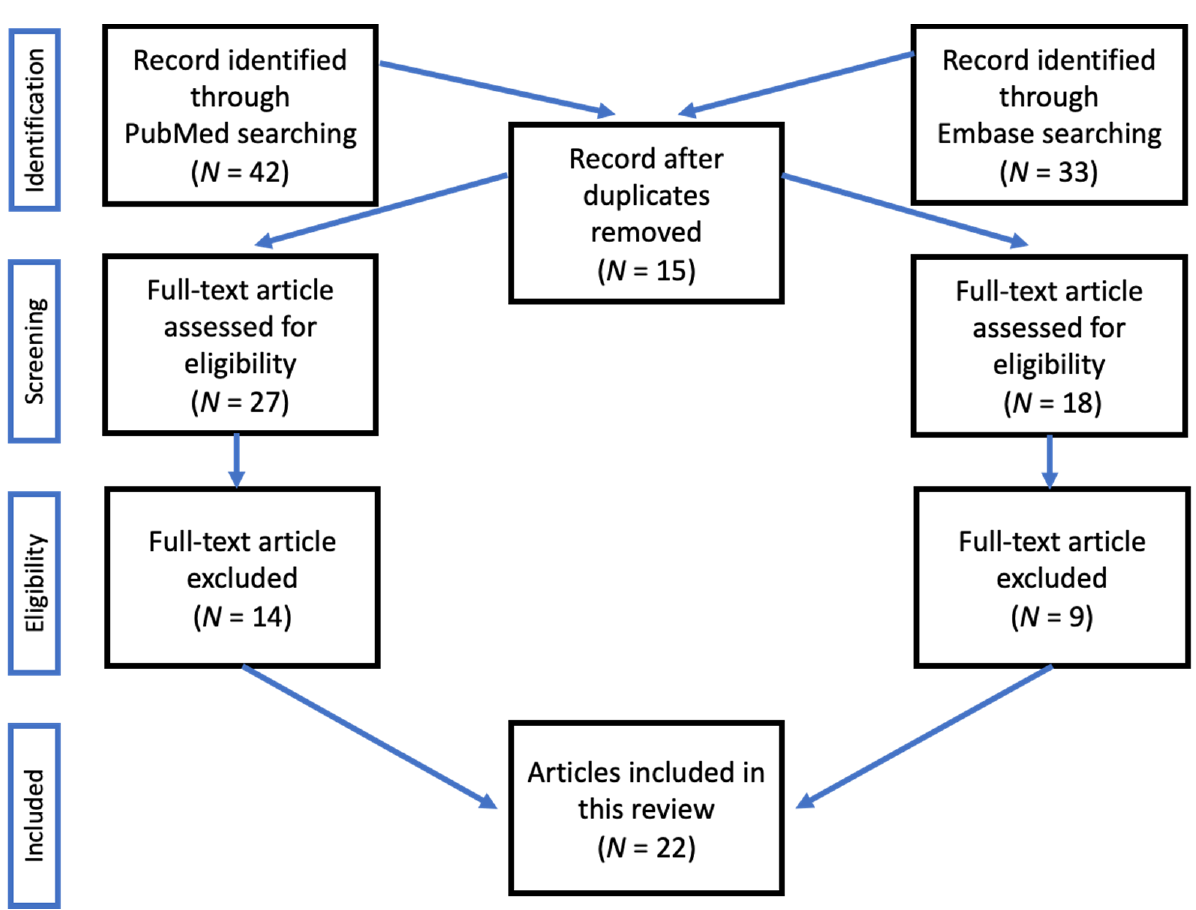
Figure 1. Flow diagram of study selection process.